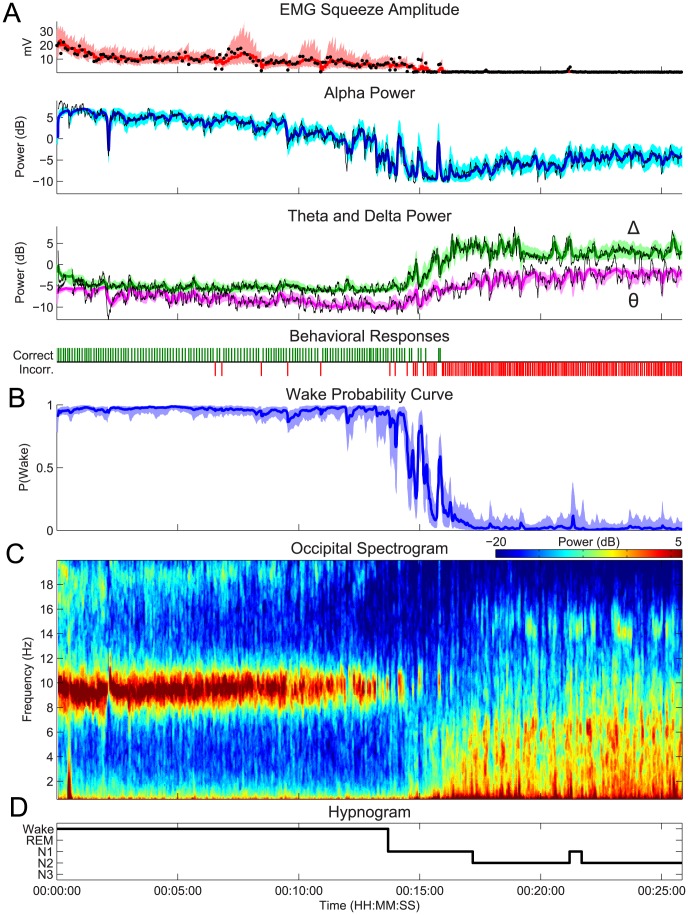
Fitting the model to experimental data during the course of sleep initiation.(A) The simultaneously observed EMG (black dots), and EEG observations (black curves), and behavioral responses (green  =  correct, red  =  incorrect) from the experiment are used to estimate the wake probability curve (B), which shows Pr(Wake), the probability of a correct response given the EEG and EMG data, over time. The wake probability curve acts as a statistically principled means of tracking the dynamics sleep initiation, and agrees well with features of the EEG spectrogram (C), the clinical hypnogram (D). In (A) the model estimates of the EMG and EEG mean (curves) and 95% confidence intervals (shaded regions) are shown (EMG: red, alpha: cyan, theta: magenta, delta: green). For all state estimates, we compute the distribution medians (colored curves), and 95% confidence intervals (shaded regions) of the model estimates.